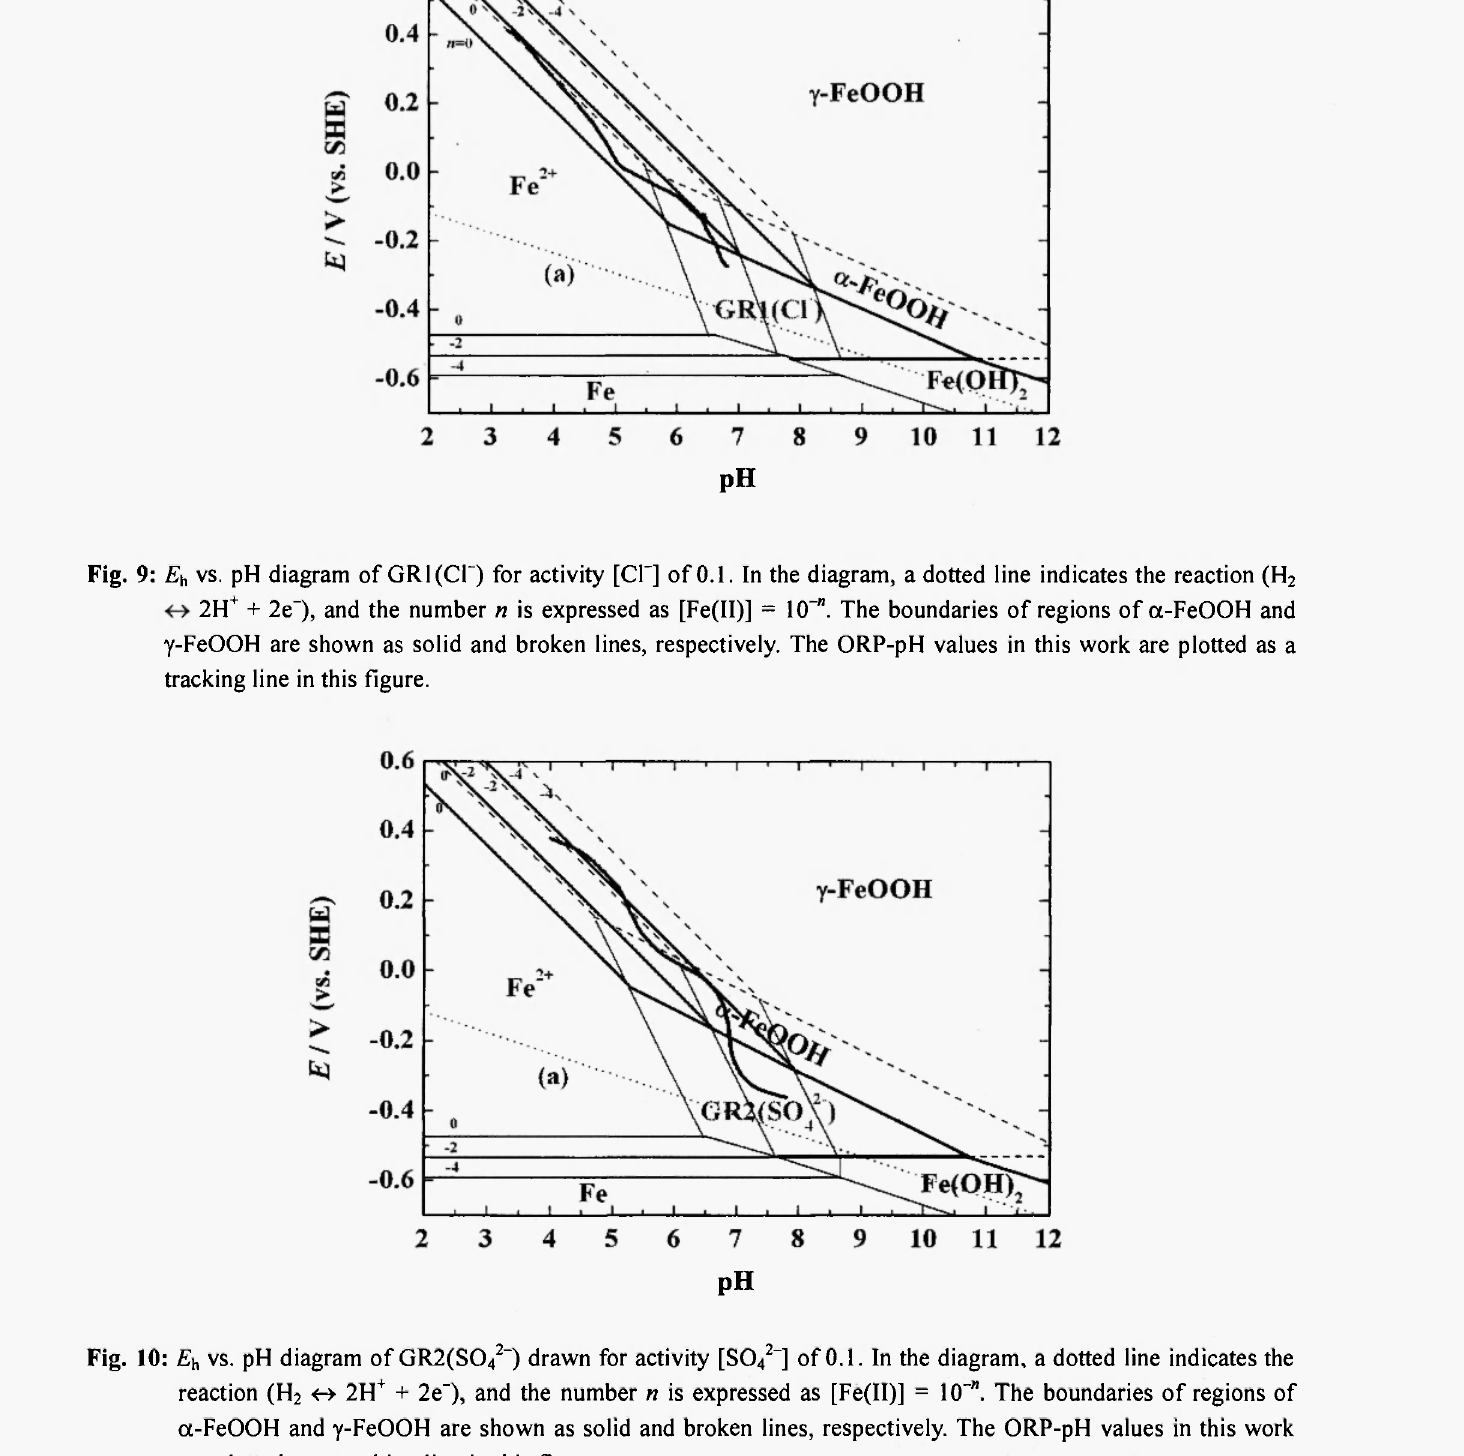
Fig. 10: E h vs. pH diagram of GR2(S0 42 ") drawn for activity [S0 42- ] of 0.1. In the diagram, a dotted line indicates the reaction (H 2 <-> 2H + + 2e~), and the number η is expressed as [Fe(II)] = 10"". The boundaries of regions of α-FeOOH and γ-FeOOH are shown as solid and broken lines, respectively. The ORP-pH values in this work are plotted as a tracking line in this figure.